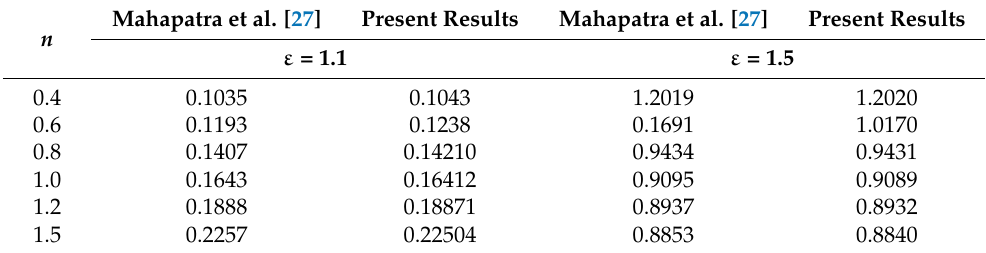
Table 3. Comparison of F (cid:48)(cid:48) ( 0 ) for various values of n and a/c at n = 1 and λ = Nr = 0.